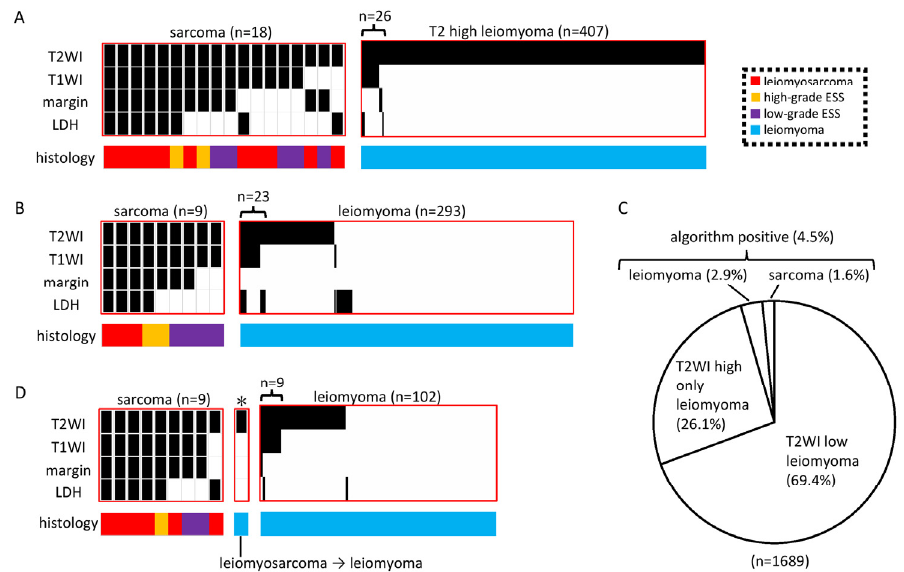
Figure 1. Differentiation of uterine sarcoma from uterine fibroids by MRI images and LDH levels. ( A ) Analysis of the Kyoto cohort. All 18 sarcomas had a high T2, and the others either had a high T1, unclear margins, or high LDH (the diagnostic algorithm for sarcoma). Of the 1369 myomas, 407 had a high T2. ( B ) Analysis of Kindai Cohort I. All nine sarcomas were algorithm-positive, and 23 of the 293 myomas were algorithm-positive. ( C ) Total of the Kyoto Cohort and Kindai Cohort I. Of 1689 cases, 4.5% were algorithm-positive. ( D ) Analysis of Kindai Cohort II. One case was originally diagnosed as sarcoma but was found to be myoma by a pathological review after being algorithm-negative. All other nine sarcomas were algorithm-positive and, of 102 randomly selected uterine fibroids, nine were algorithm-positive. * A case that was originally diagnosed as a sarcoma, but was found to be a myoma by pathology review after an algorithm-negative result.